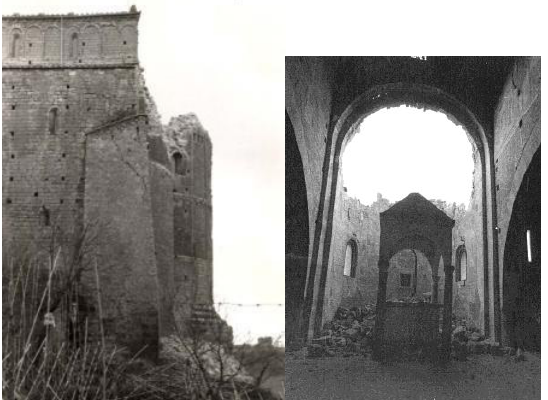
Figure 1. Outside (left) and inside (right) view of the dome after the earthquake in 1971.